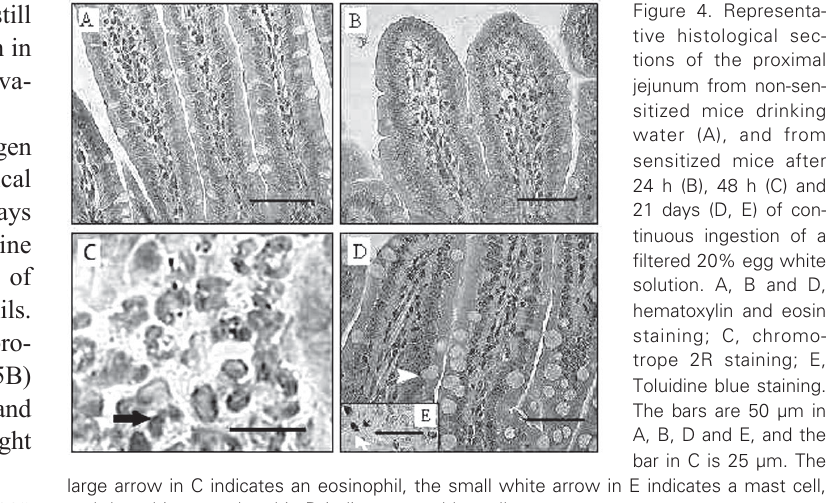
Figure 5. Eosinophils (A), mucus production (B), mast cells (C), and mucosa height (D) in the jejunum of BALB/c mice sensi- tized with 10 µg ovalbumin (OVA) plus 1 mg Al(OH) 3 after continuous ingestion of an egg white solution (EWS). The open bars indicate the control group (Ova - /EWS - ) and the closed bars represent the allergic group (Ova + /EWS + ) who ingested the EWS. Data are reported as means ± SEM of number of cells (A, C), mucus production (B; PAS = periodic acid Schiff), or mucosa height (D) for 6 mice in each group *P < 0.05 com- pared to control Ova - /EWS - (ANOVA-Student t -test).